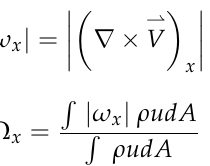
Figure 3. Static pressure, Mach number, and static temperature contours in the combustor X–Z plane.